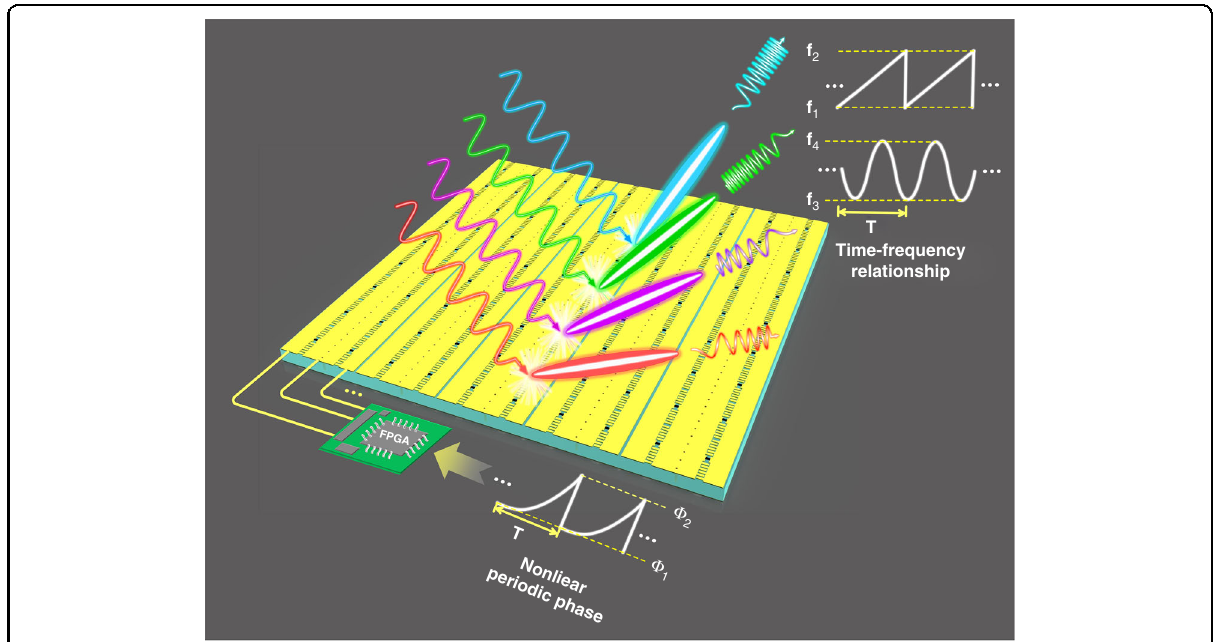
Fig. 1 Concept illustration of waveform generations and beam shaping of various FMCWs by a programmable STCM with nonlinearly periodic phases. Under the control of a FPGA that offers external nonlinear periodic voltage control signals, the different types of FMCW signals can be synthesized as required at the same STCM platform. By further optimizing the initial voltage distributions among different regions of the metasurface, the propagation directions of the FMCW beams can be manipulated